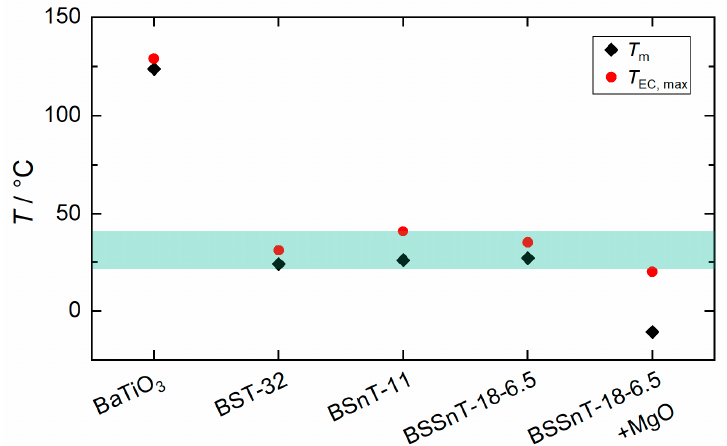
Figure 11. Compilation of temperature of maximum electrocaloric temperature change ( T EC,max ) measured at ∆ E = 2 V µ m − 1 and temperature of maximum relative permittivity ( T m ) for bulk ceramics BaTiO 3 , Ba 0.68 Sr 0.32 TiO 3 (BST-32), BaSn 0.11 Ti 0.89 O 3 (BSnT-11), [9] BSSnT-18-6.5 and BSSnT-18-6.5 with x MgO = 1%.